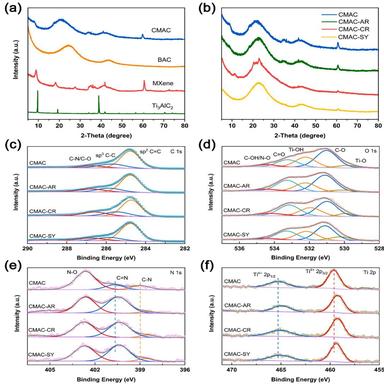
XRD patterns of (a) CMAC, BAC, MXene, Ti3AlC2 and (b) CMAC before and after the AR, CR and SY adsorption. XPS spectra of (c–f) C 1s, O 1s, N 1s and Ti 2p of CMAC composite before and after AR, CR and SY adsorption.